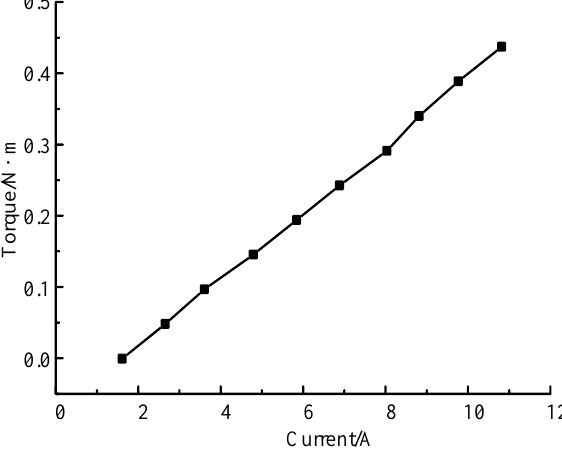
Figure 19. Measured torque and current curves of the improved winding at 3000 rpm.